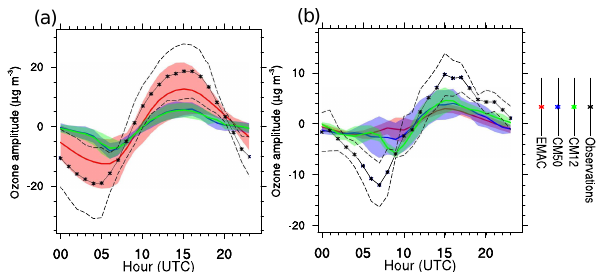
Figure 11. The same as Fig. 10 but for the subset of stations which are located in all three model instances.